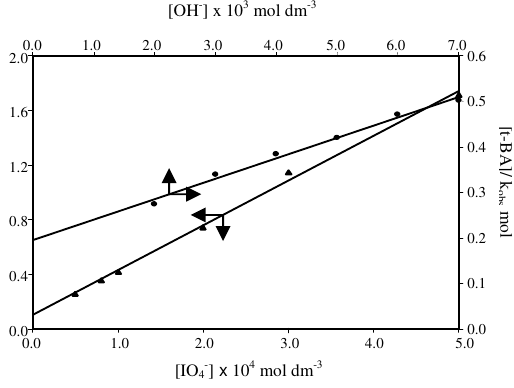
Figure 2. Verification of rate law (8) for the ooxidation of t -butylbenzylamine by diperiodatoargentate(III) in aqueous alkaline medium at 30 0